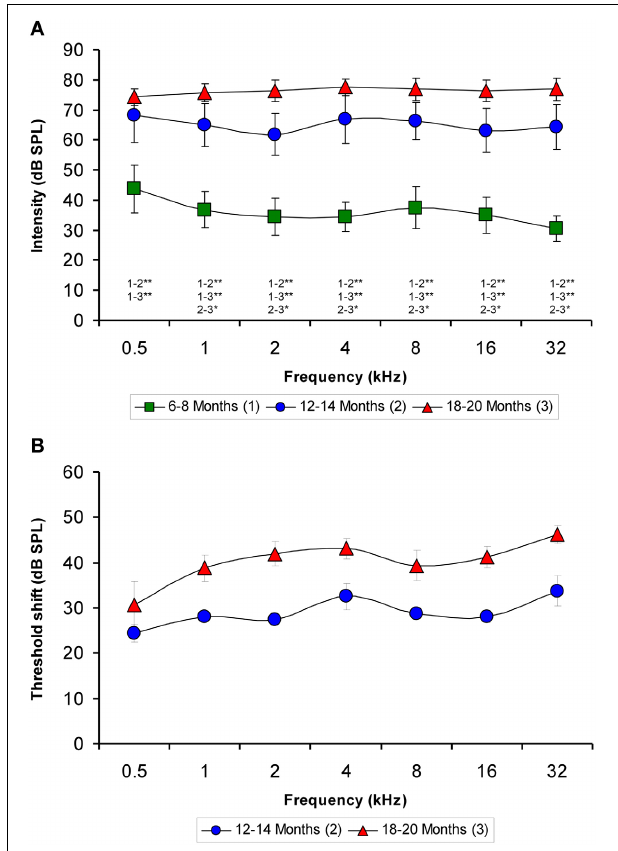
FIGURE 1 | Line graphs illustrating the relationship between the auditory thresholds and the frequencies tested for each age group. Note that the mean values of the older groups rose as the age of the rats increased (A) . Compared to the 6- to 8-month-old rats, the threshold shift in the 12- to 14-month-old rats ranged from approximately 24–33dB and in the 18- to 20-month-old rats rose from approximately 30–46dB (B) . ∗ p < 0 . 05; ∗∗ p < 0 . 01.